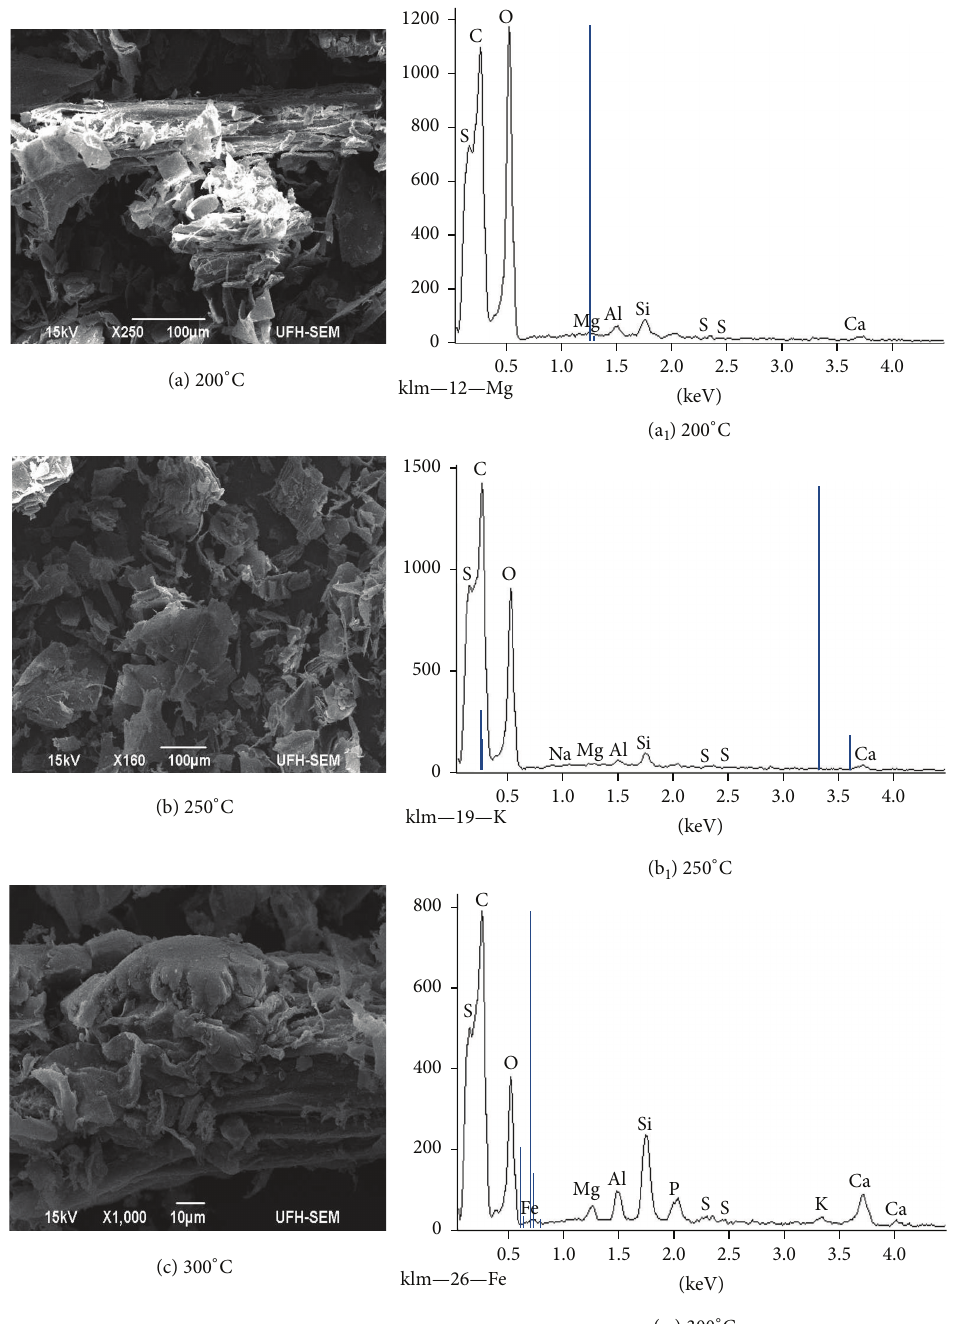
Figure 4: SEM images of sugarcane bagasse torrefied at different temperatures and their respective EDX spectrums with torrefaction for (a) 200 ∘ C, (b) 250 ∘ C, and (c) 300 ∘